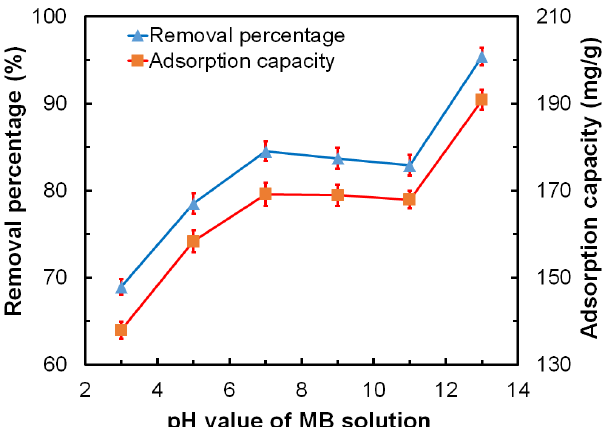
Figure 10. Influence of the pH value on the removal percentage and adsorption capacity of the GO ‐ CNT/AC composites [Conditions: adsorbent amount = 100 mg, MB solution amount = 100 mL, MB solution concentration = 200 mg/L, adsorption time = 300 min, CNT concentration = 3 mg/mL, pH values were 3, 5, 7, 9, 11 and 13, respectively].